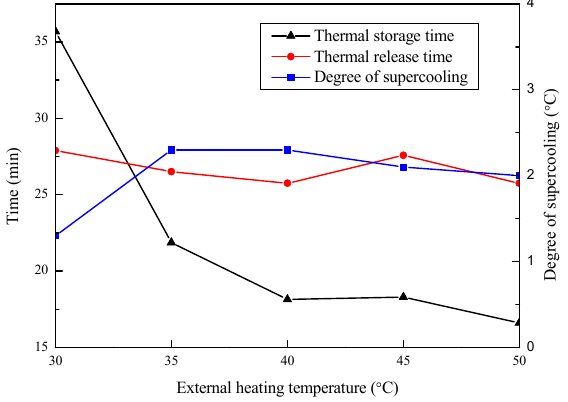
Figure 14. Effect of ambient temperature on the thermal storage and release time and the subcooling of the Na 2 SO 4 ·10H 2 O eutectic CPCMs.